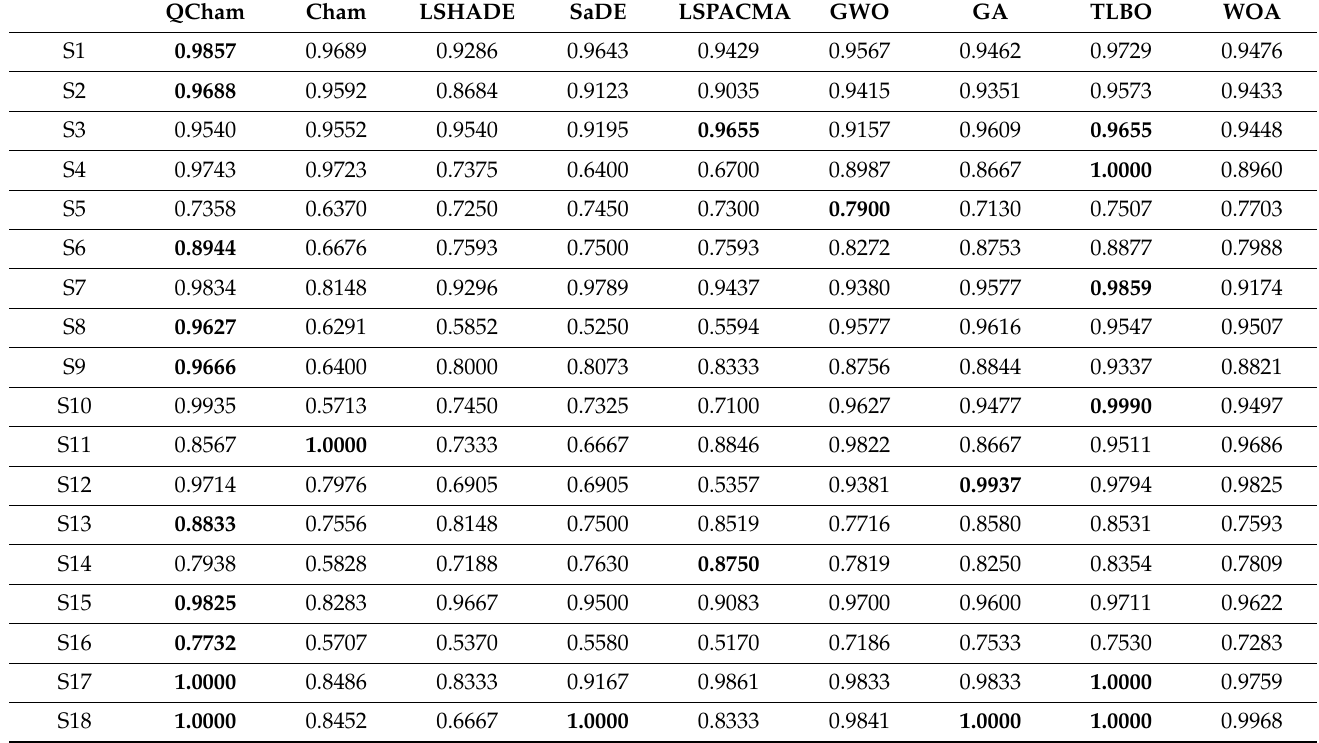
Table 7. Accuracy results for all methods.